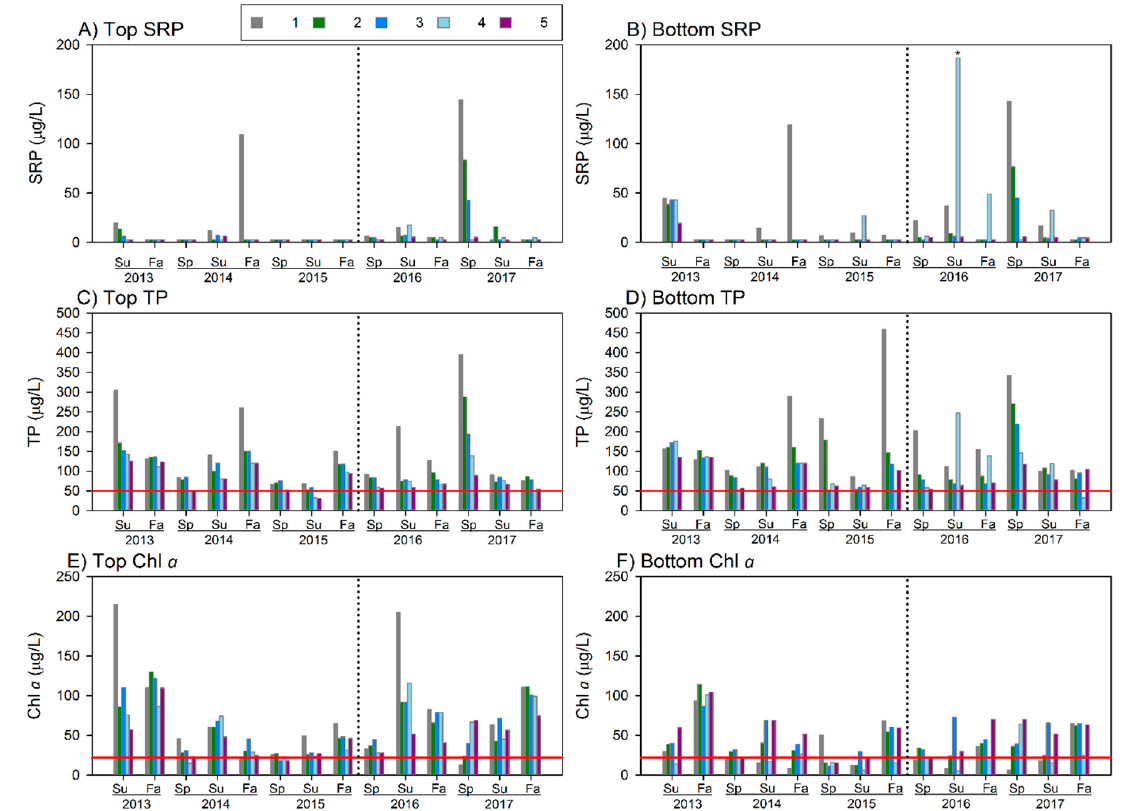
Figure 11. SRP, TP, and Chl a concentrations measured at the five monitoring stations in Lake Macatawa from 2013 through 2017. The red horizontal lines on TP indicate the interim TMDL goal of 50 µ g/L; red horizontal lines on Chl a figures indicate the hypereutrophic boundary of 22 µ g/L used by MDEQ for assessing chlorophyll in Lake Macatawa (Holden 2014). Summer 2016 site 4 bottom depth SRP sample ( B , asterisked) is a likely outlier due to sediment disturbance.